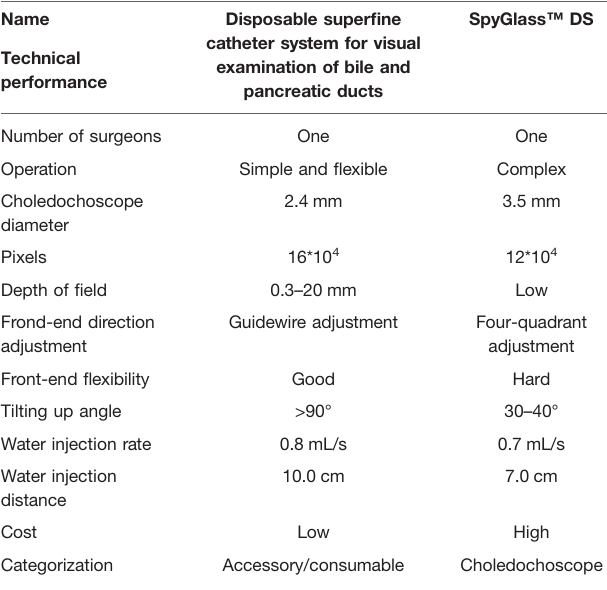
TABLE 2 | Performance